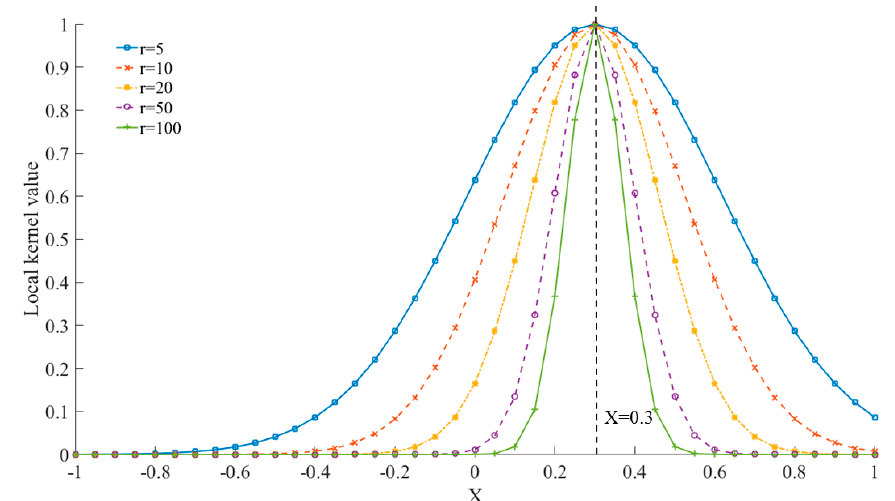
Figure 2. Data distribution of local kernel (Gaussian kernel, test point X = 0.3).